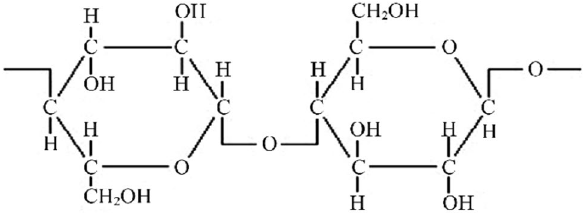
Fig. 3 Cellulose hydrogen bond (Prasad et al., 2015; Zaki et al., 2018)